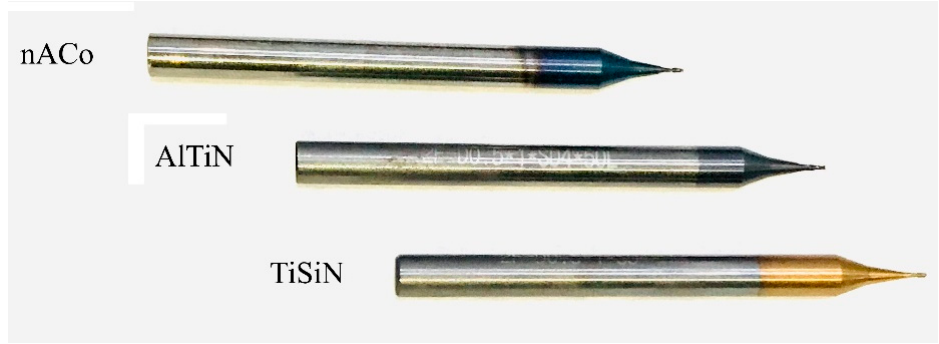
Figure 2. Different coated microdrill tools used in the experiments. Table 4. Cutting tool details and specifications.